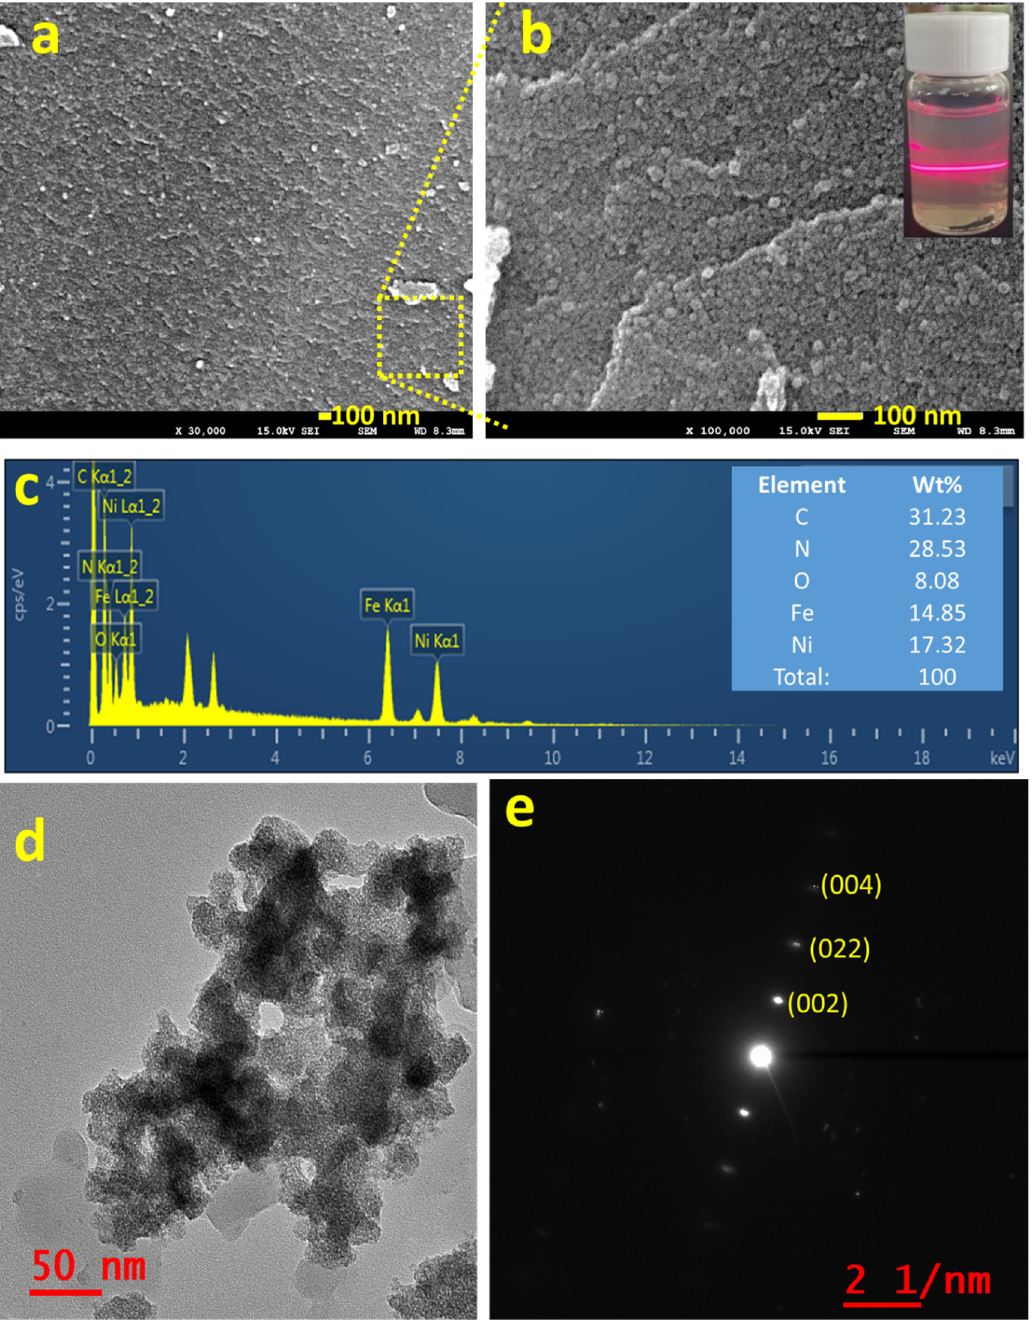
Figure 2. ( a , b ) FE-SEM images (inset of b shows the digital photographs of Tyndall light-scattering experiment), ( c ) EDS spectra (inset shows the elemental wt. %), ( d ) HR-TEM image, and ( e ) SAED pattern of